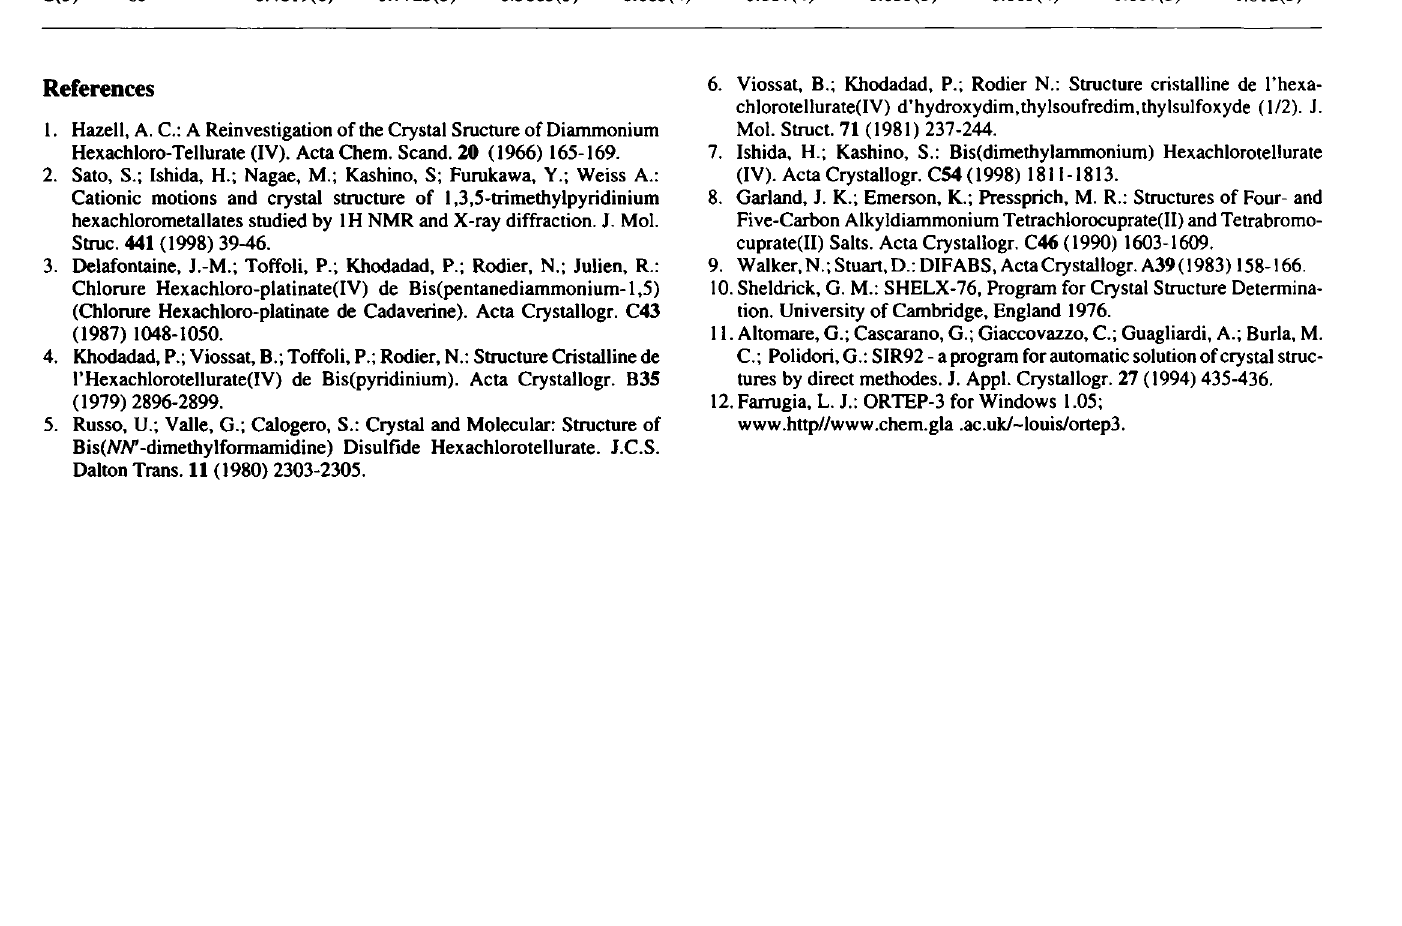
Table 3. Atomic coordinates and displacement parameters (in A 2